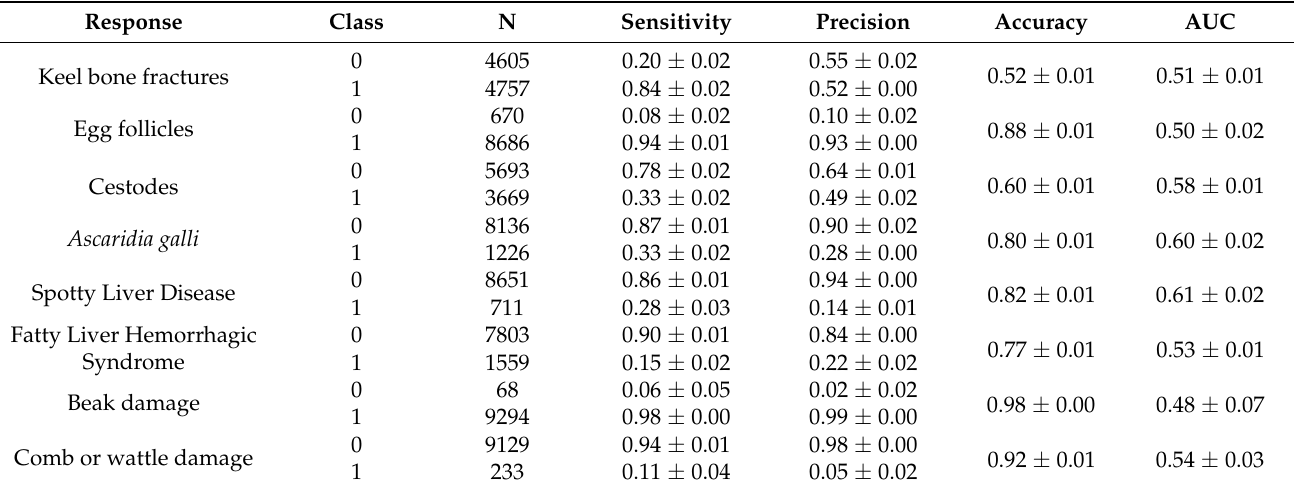
Table 2. Performance results for the random forest classifiers trained on each response. The mean sensitivity, precision, accuracy, and Area Under the Curve (AUC) ( ± standard deviation) are presented along with the number (N) of data points in each